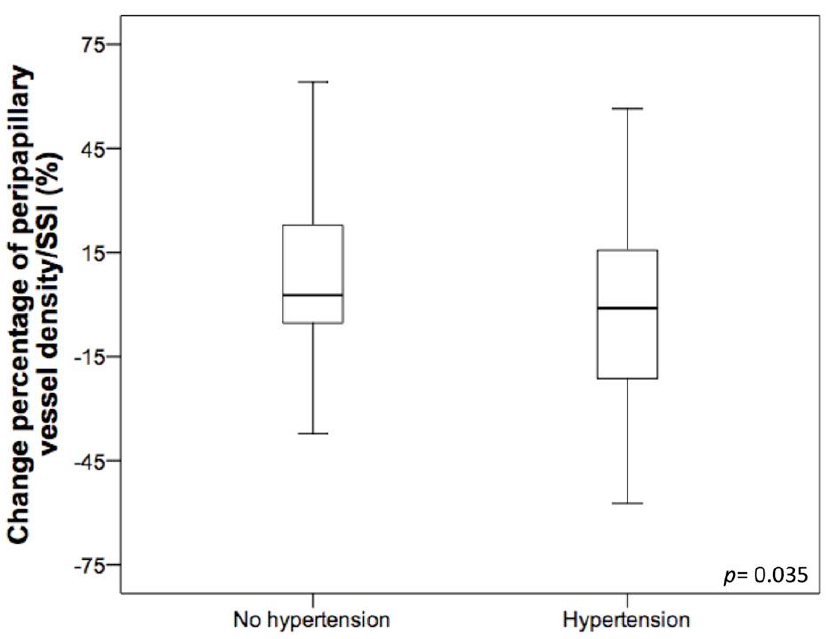
Figure 5. Percentage change in peripapillary vessel density/signal strength index (SSI) after the 6-month topical carteolol treatment in patients with normal-tension glaucoma with and without hypertension. (Sample size: no hypertension n = 53, hypertension n = 27, p : p value of univariate analysis)